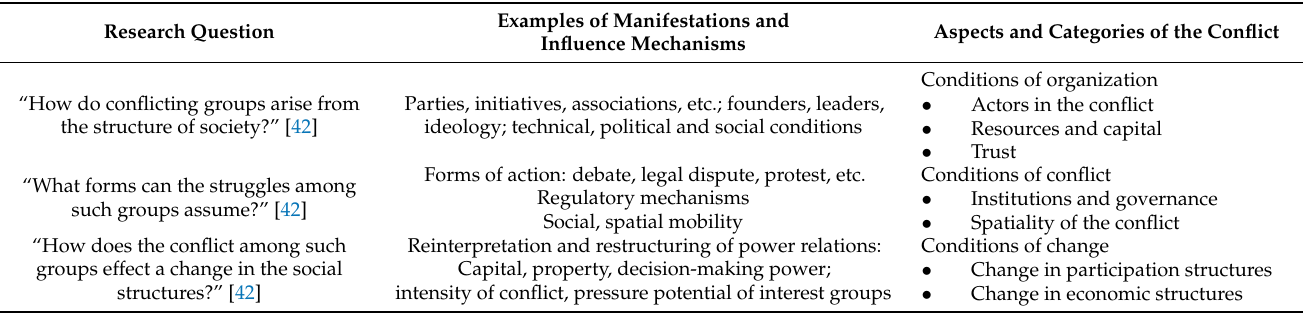
Table 1. Framework for analyzing conflict dynamics (own representation following Dahrendorf